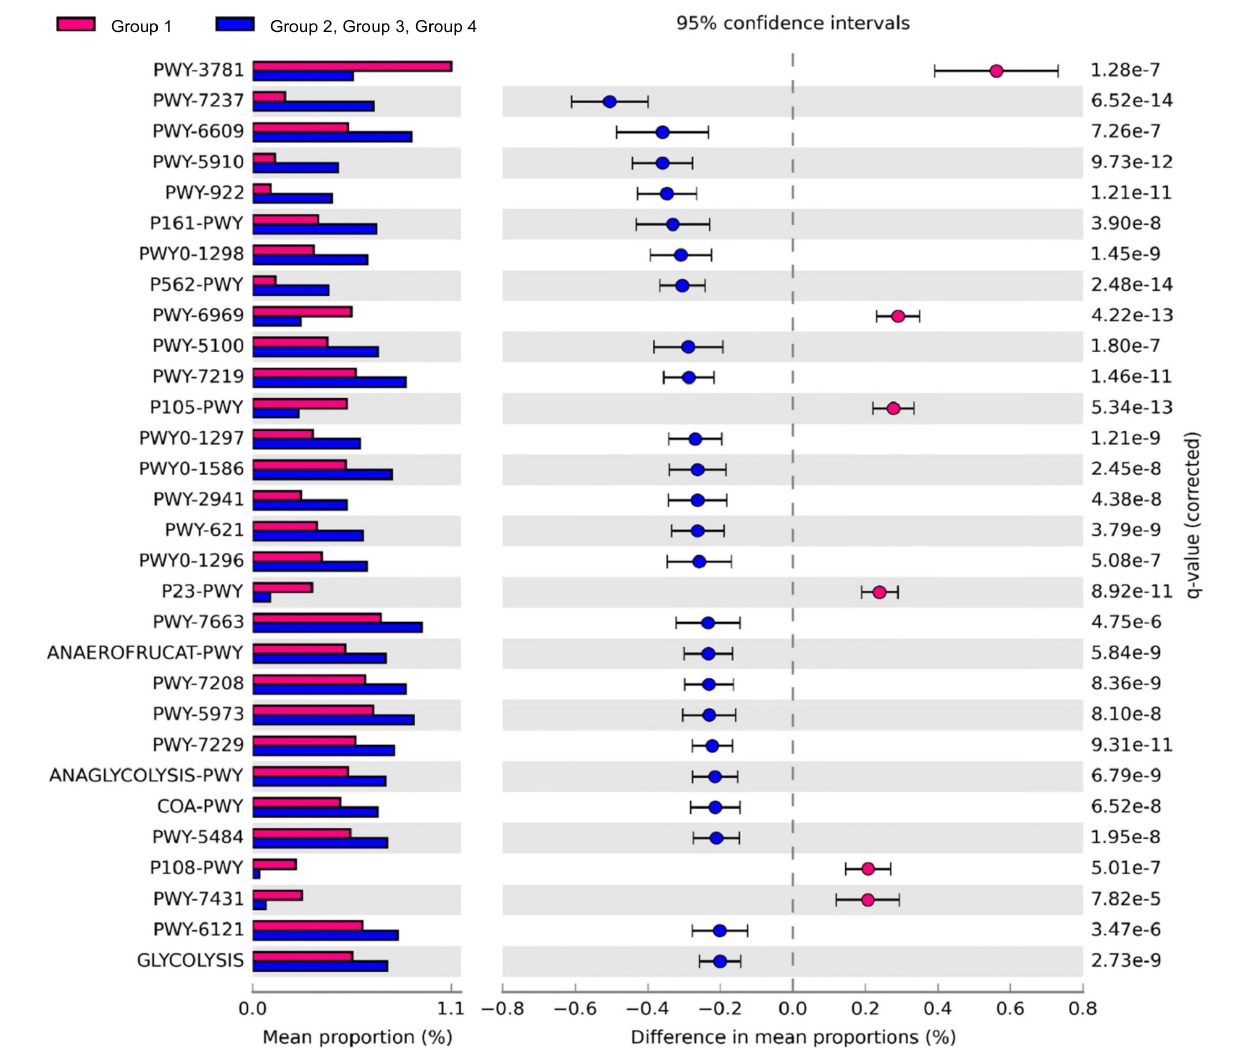
(Samelis et al., 2006; Doulgeraki et al., 2010; Pothakos et al.,